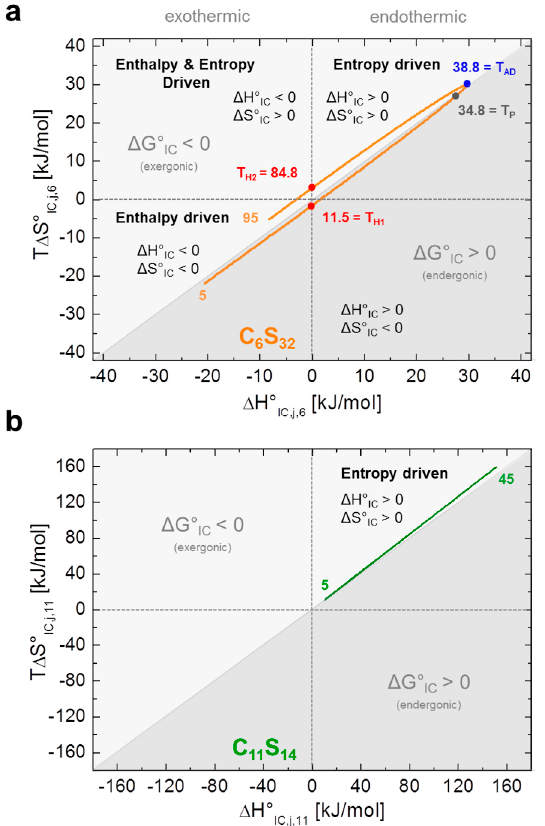
Figure 5. Energetic fingerprint of the interconversion process K IC, j , k . Both energetic fingerprints are depicted in the style of ref. [12]. ( a ) Energy plot of entropy ( T ∆ S ◦ IC, j ,6 ) versus enthalpy ( ∆ H ◦ IC, j ,6 ) is shown from the dynamic hydrophobic interconversion equilibrium K IC, j ,6 of 16-DSA in polymer C 6 S 32 . The apolar dehydration temperature ( T AD = 38.8 ◦ C) is highlighted in blue, the performance temperature ( T P = 34.8 ◦ C) in gray and the enthalpy compensation temperatures ( T H1 = 11.5 ◦ C and T H2 = 84.8 ◦ C) in red; ( b ) The energy plot of entropy ( T ∆ S ◦ IC, j ,11 ) versus enthalpy ( ∆ H ◦ IC, j ,11 ) of the dynamic hydrophobic interconversion process K IC, j ,11 of 16-DSA in polymer C 11 S 14 exhibits almost perfect EEC behavior. Exergonic and endergonic regions of the plot have been separated by a diagonal line and are color coded in different shades of gray. The orange and green inset numbers denote the respective temperatures.